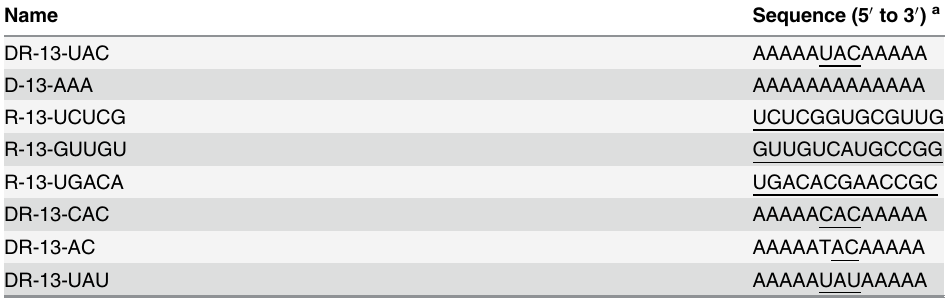
Table 1. Fluorescent-labeled oligonucleotides used in fluorometric assay.